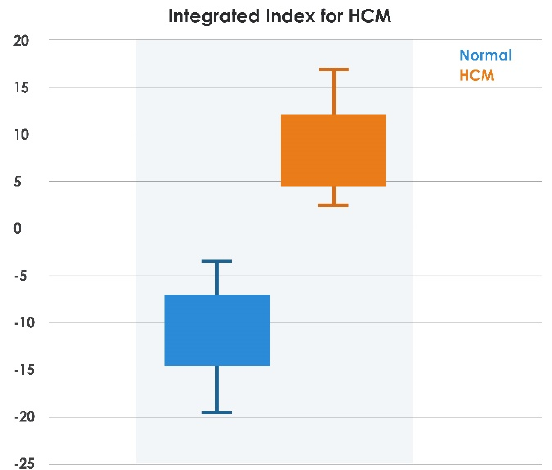
Figure 11. Classification using proposed IIHCM methodology with the LDPRes870 feature on divided training (70%) and testing data (30%).